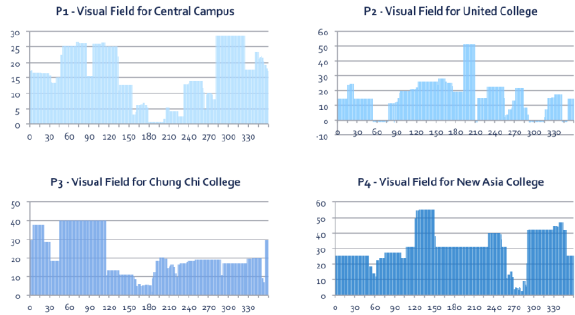
Figure 8. Visual Field for 4 Experimental Sites in the Preliminary Research